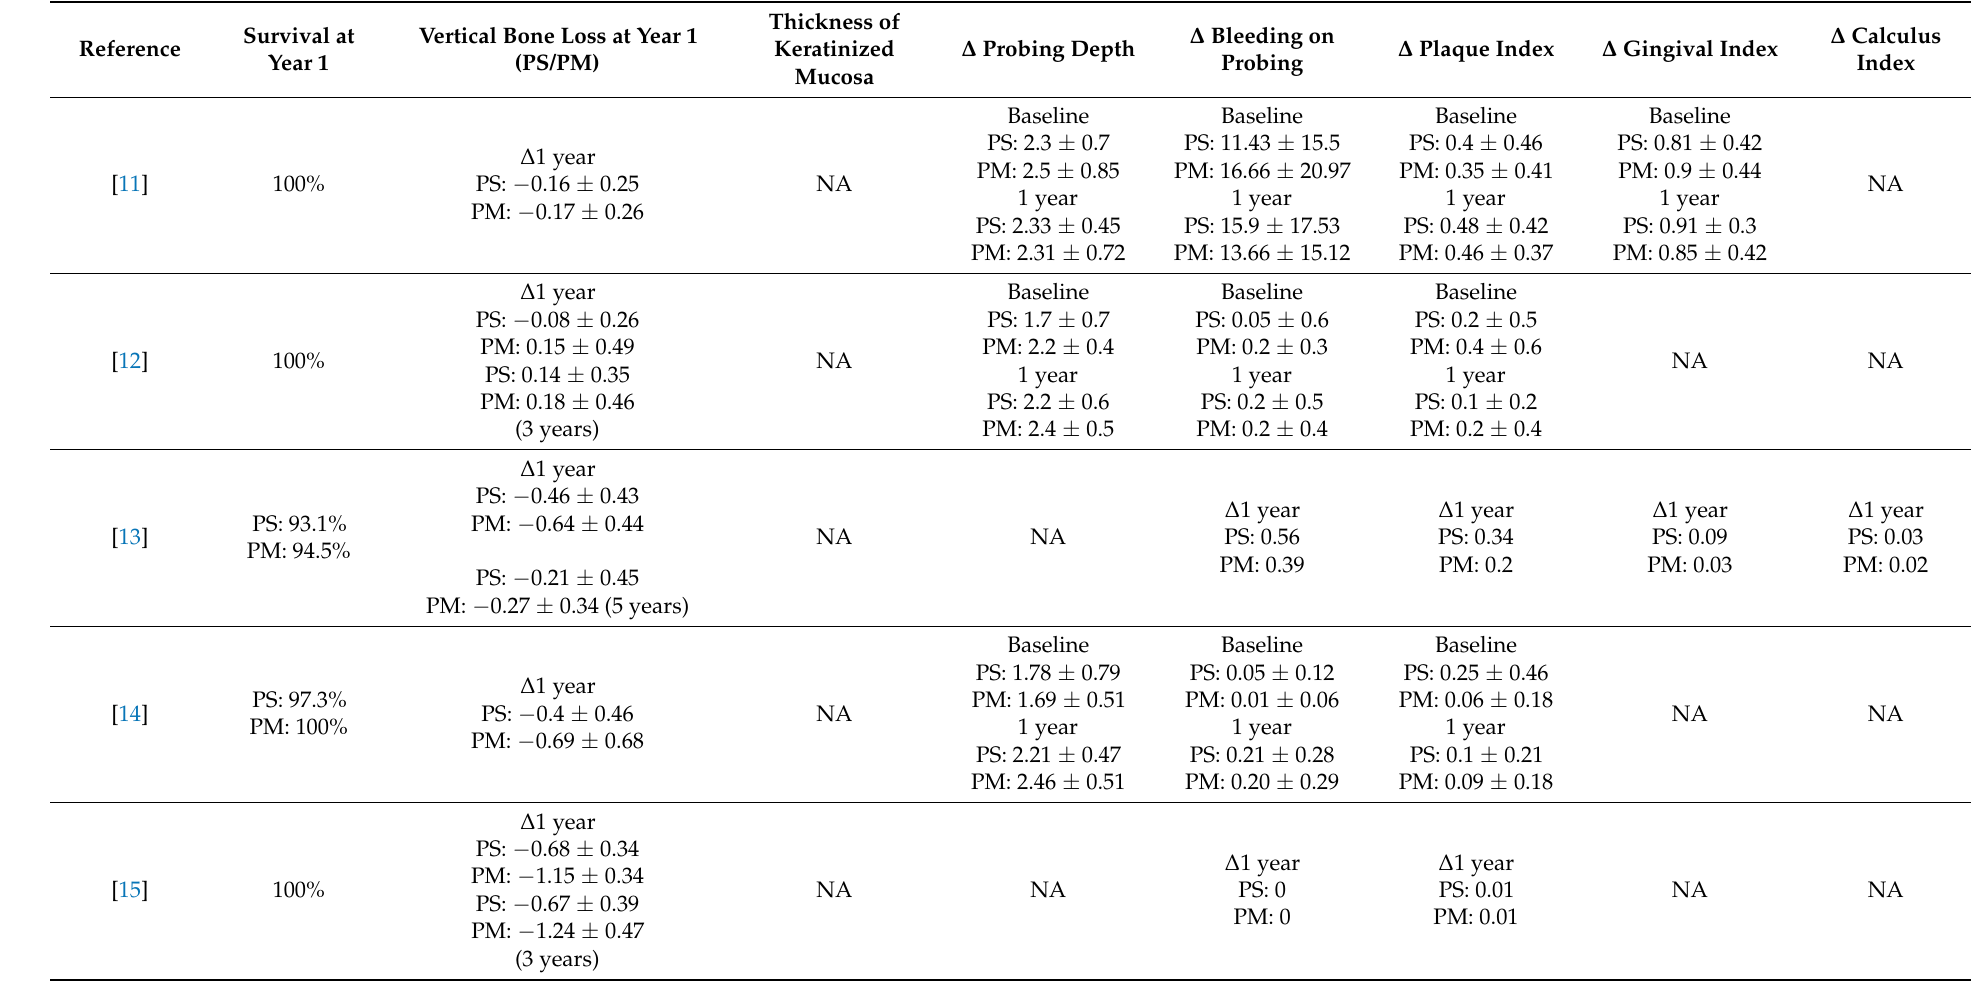
Table 3. Peri-implant clinical